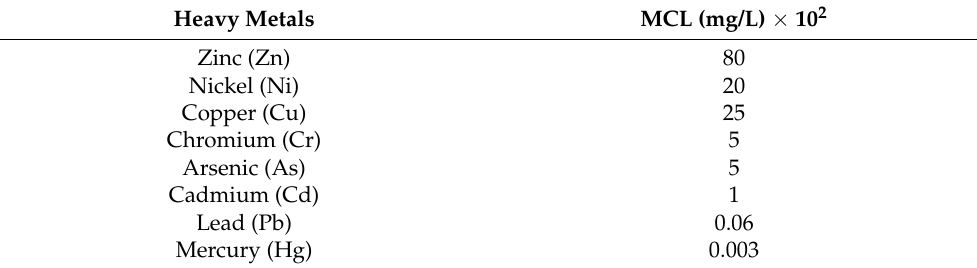
Table 1. Metal toxicity